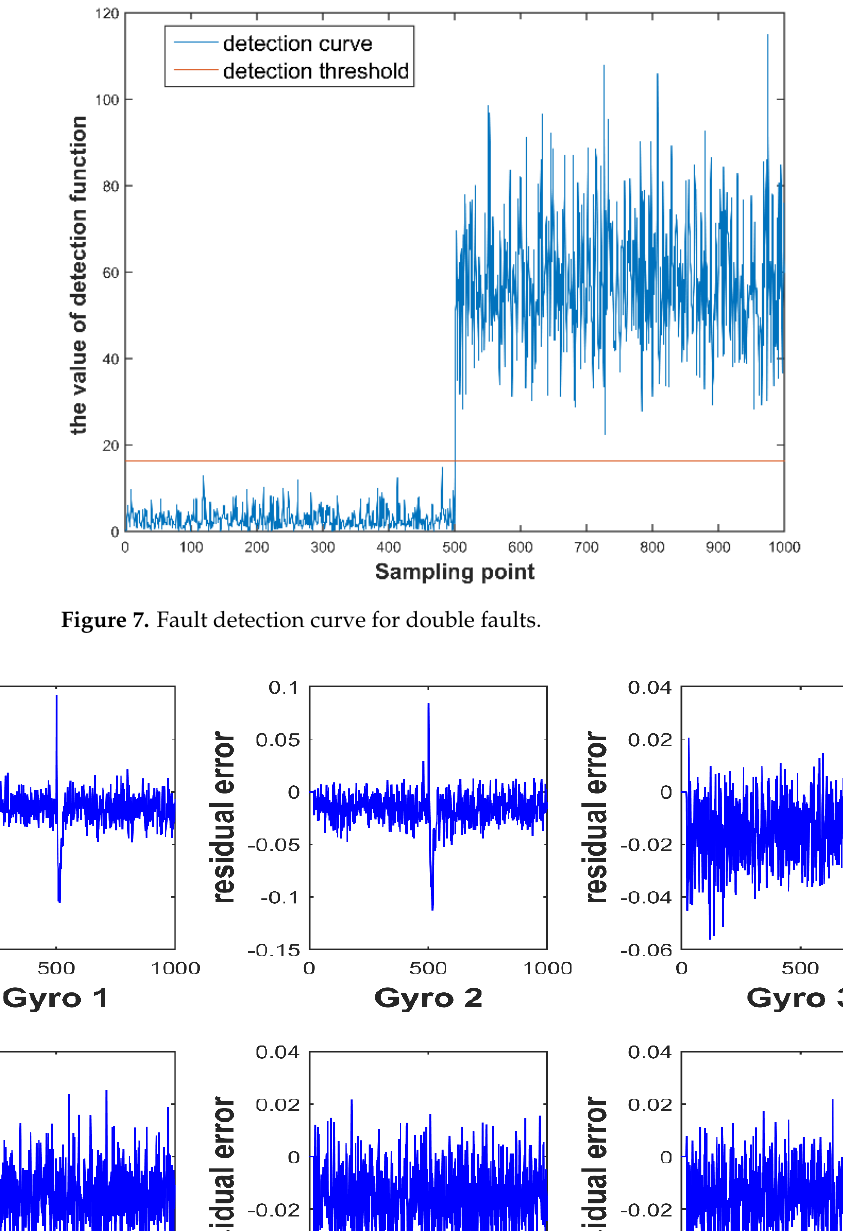
Figure 6. Residual vector values for Gyro 1–6 injection of